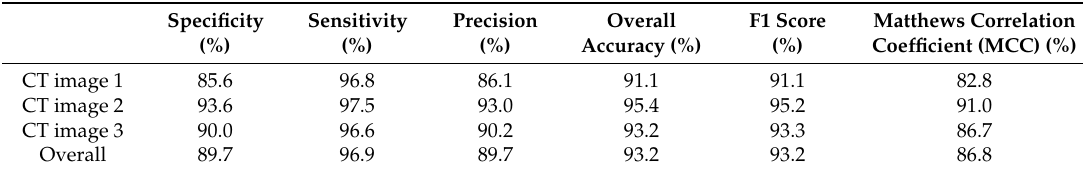
Table 2. Performance evaluation metrics by the confusion matrix.